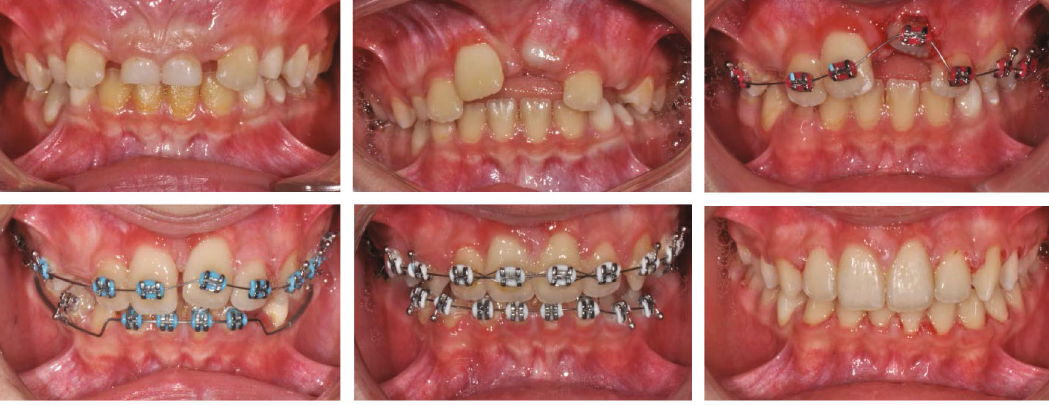
Figure 2: Treatment progress.